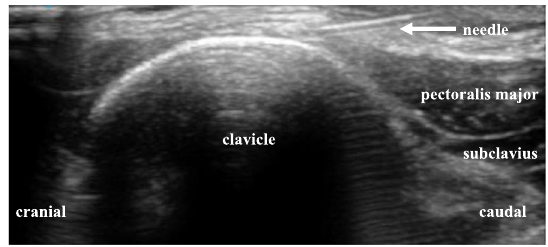
Fig. 1 Ultrasound image of clavipectoral fascial plane